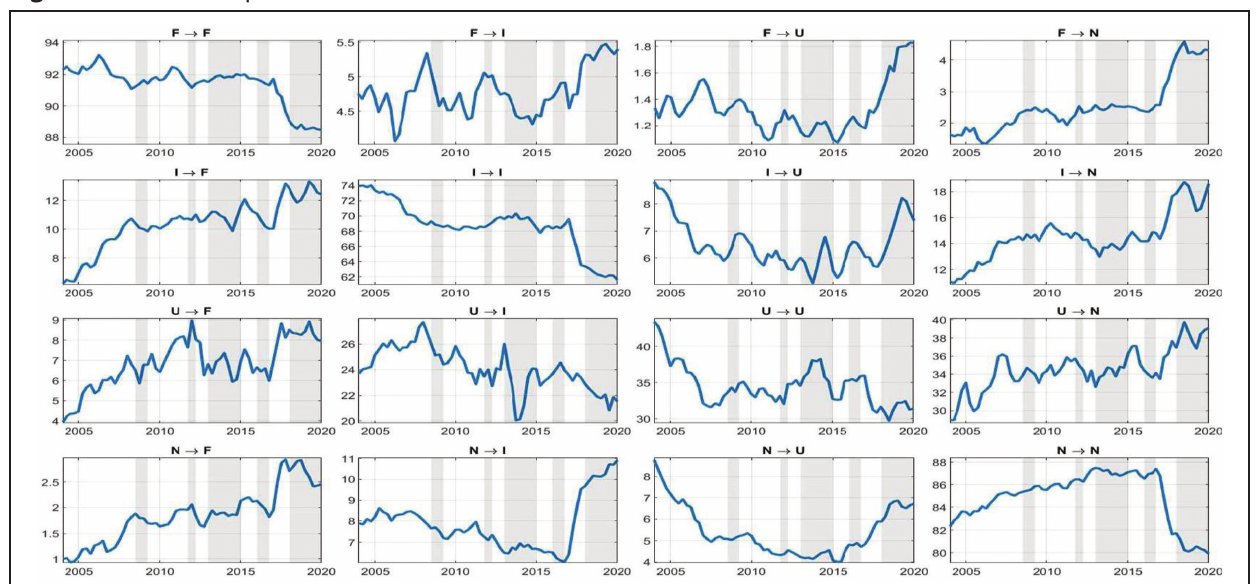
Figure 4 Transition probabilities in%.